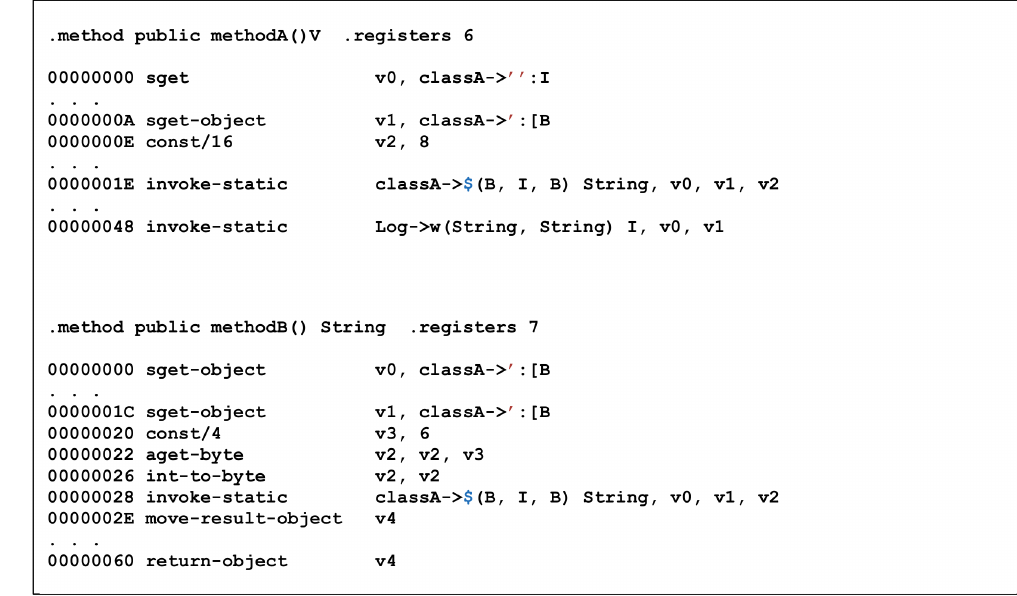
Figure 18. Disassembled MethodA and MethodB with DexGuard .